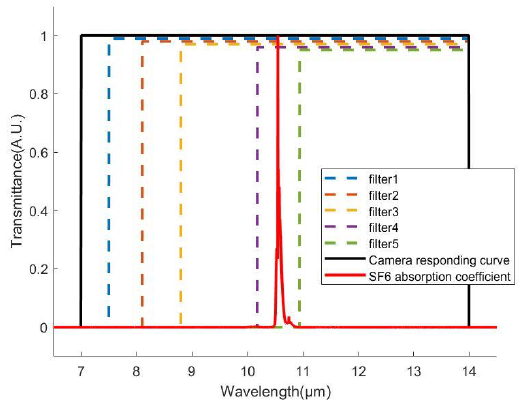
Figure 3. Spectral transmittance curve of wideband filters, camera responding curve, and absorption coefficient of SF6. All transmittance curves are shifted to be easily distinguished. SF6 absorption coefficient is normalized for clear presentation.